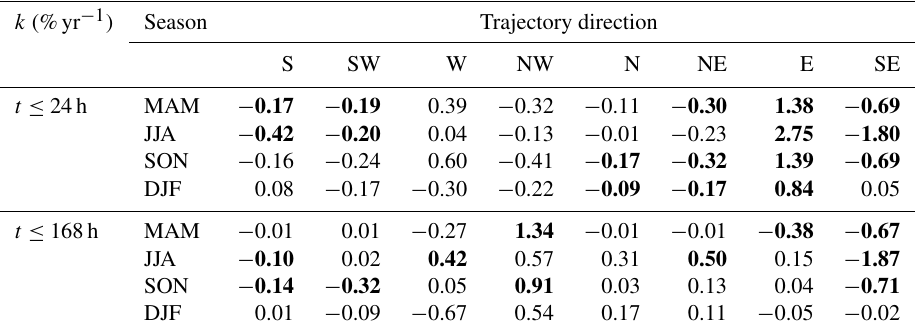
Table 1. The linear variation slope ( k ) of the 24h and 168h average trajectory direction occurrence frequencies (%yr − 1 ; numbers in bold are significant under a confidence level of